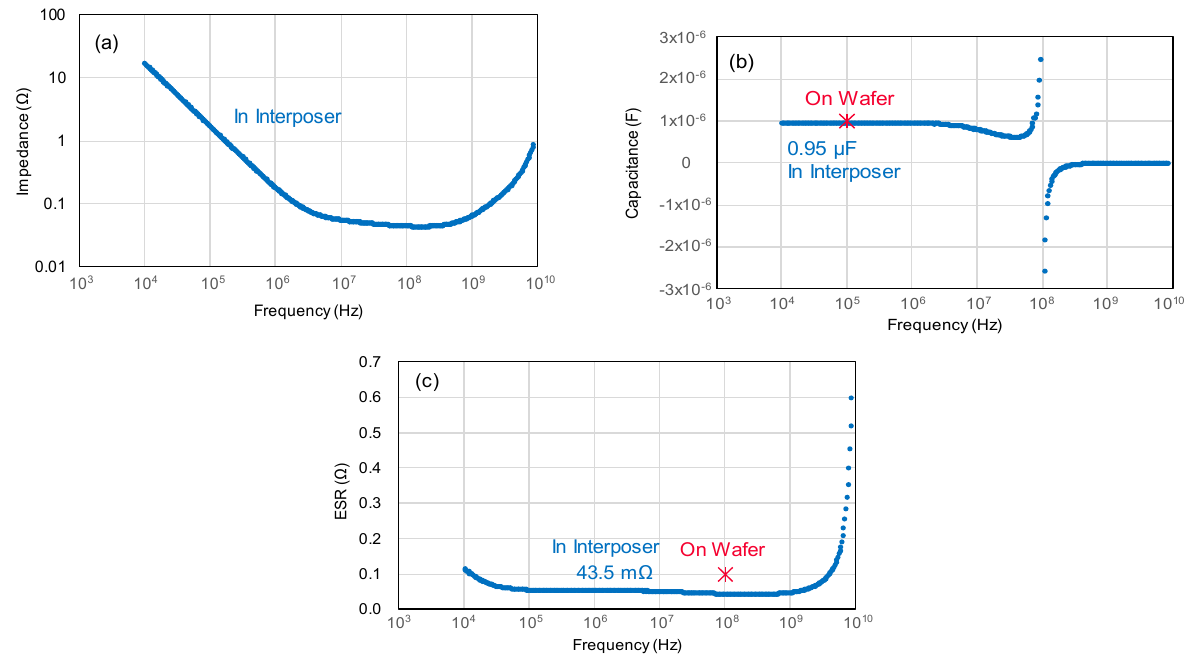
Figure 23. RF characteristics of Si capacitor embedded in functional interposer from 10 kHz to 8.5 GHz: ( a ) impedance, ( b ) capacitance, ( c ) ESR, compared to the Si capacitor before COW process indicated “On Wafter” red symbol.